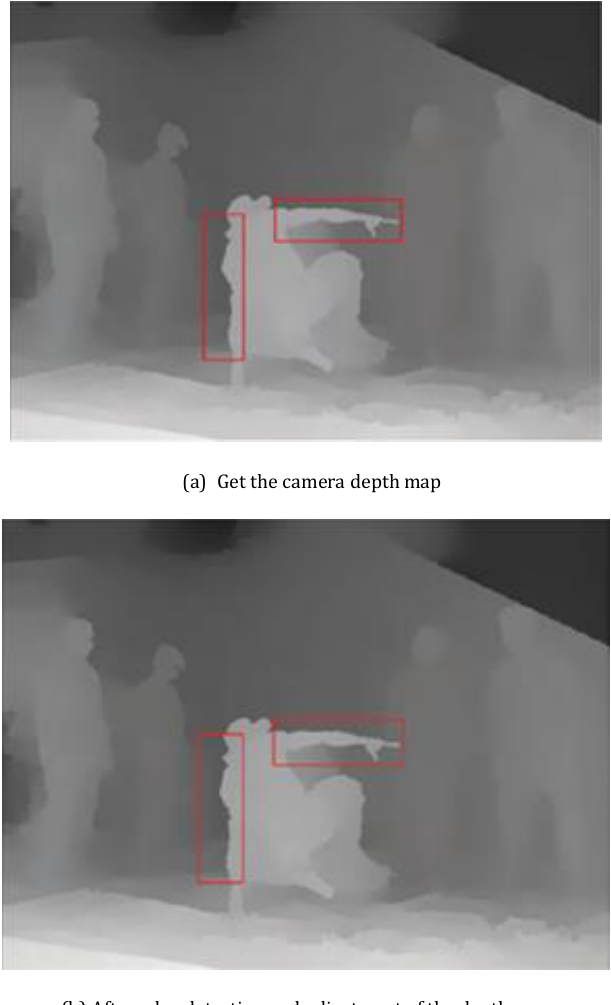
Figure 3: Before and after comparison of edge detection and depth map